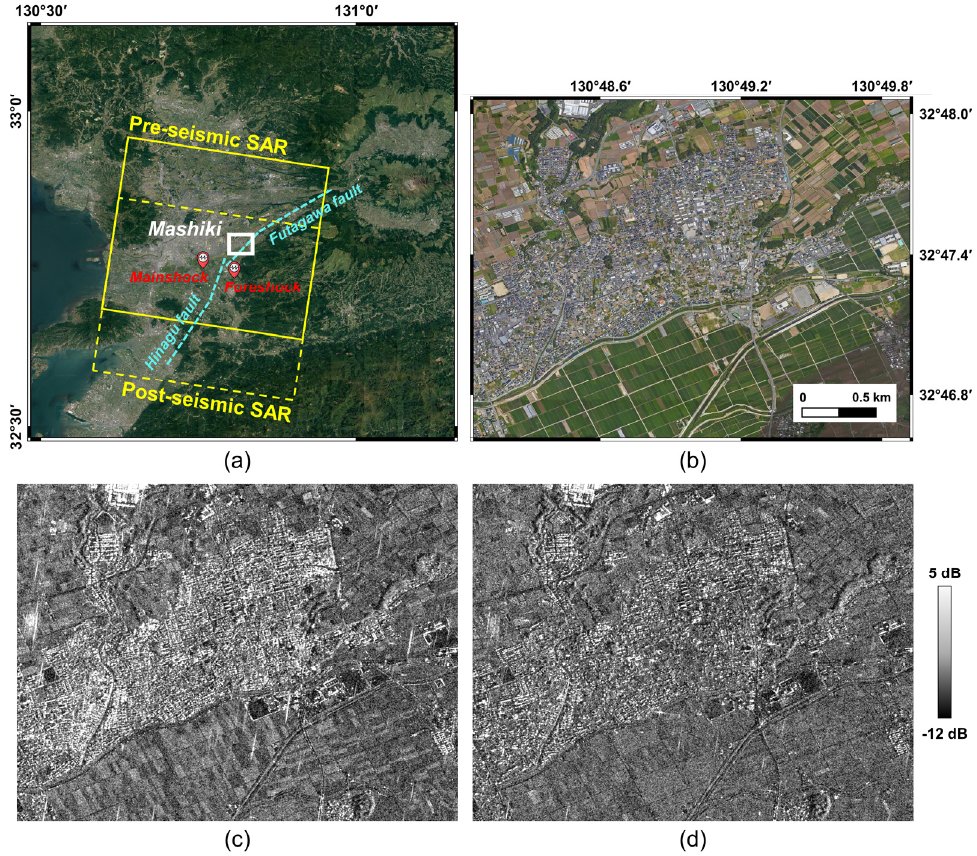
Figure 1. Study area and data: ( a ) Kompsat-5 data coverage and location of the Mashiki town study area (white rectangle) marked on Google Earth image. The cyan dashed lines illustrate the approximate location of the Hinagu and Futagawa faults. The locations of the foreshock and mainshock are also marked in ( a ). ( b ) Google Earth optical images of study sites acquired on 8 August 2018. ( c ) Pre-seismic Kompsat-5 (HH polarization). ( d ) Post-seismic Kompsat-5 (VV polarization).